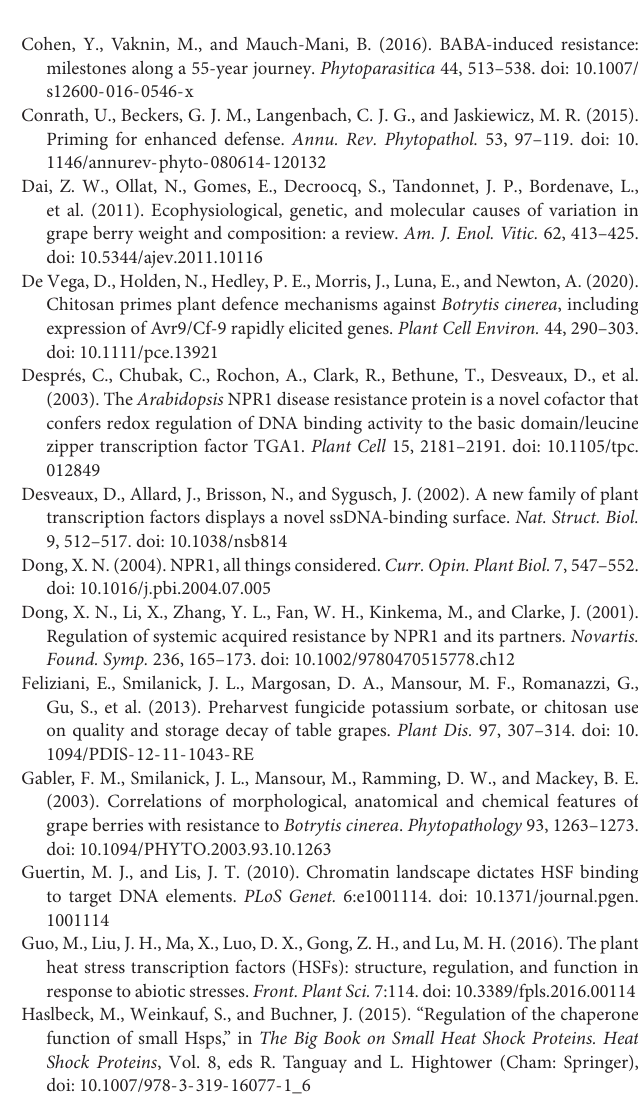
Supplementary Figure 4 | Schematic diagram of the M2CRISPR/Cas9- AtHSFB1 vector. Supplementary Figure 5 | Heat map of VvHSPs in pairwise comparisons of BABA-vs.-control, inoculation-vs.-control, BABA + inoculation-vs.-control, and BABA + inoculation-vs.-inoculation. Supplementary Figure 6 | His-tagged protein was detected by a gel image analysis (un-cropped gels). Supplementary Figure 7 | In the His pull-down assay, GST- VvNPR1 fusion protein was efficiently pull-downed by His- VvHSP24 fusion protein (un-cropped gels). Supplementary Figure 8 | EMSA of VvHSP24 binding to the HSE elements of PR1 , PR2, and PR5 (un-cropped blots). Supplementary Table 1 | Primer sequence of the used genes. Supplementary Data 1 | Promoter sequences of VvPR1 , VvPR2, and VvPR5 . HSEs (GAAnnTTC) and the translation start site (ATG) are marked in red and yellow boxed,